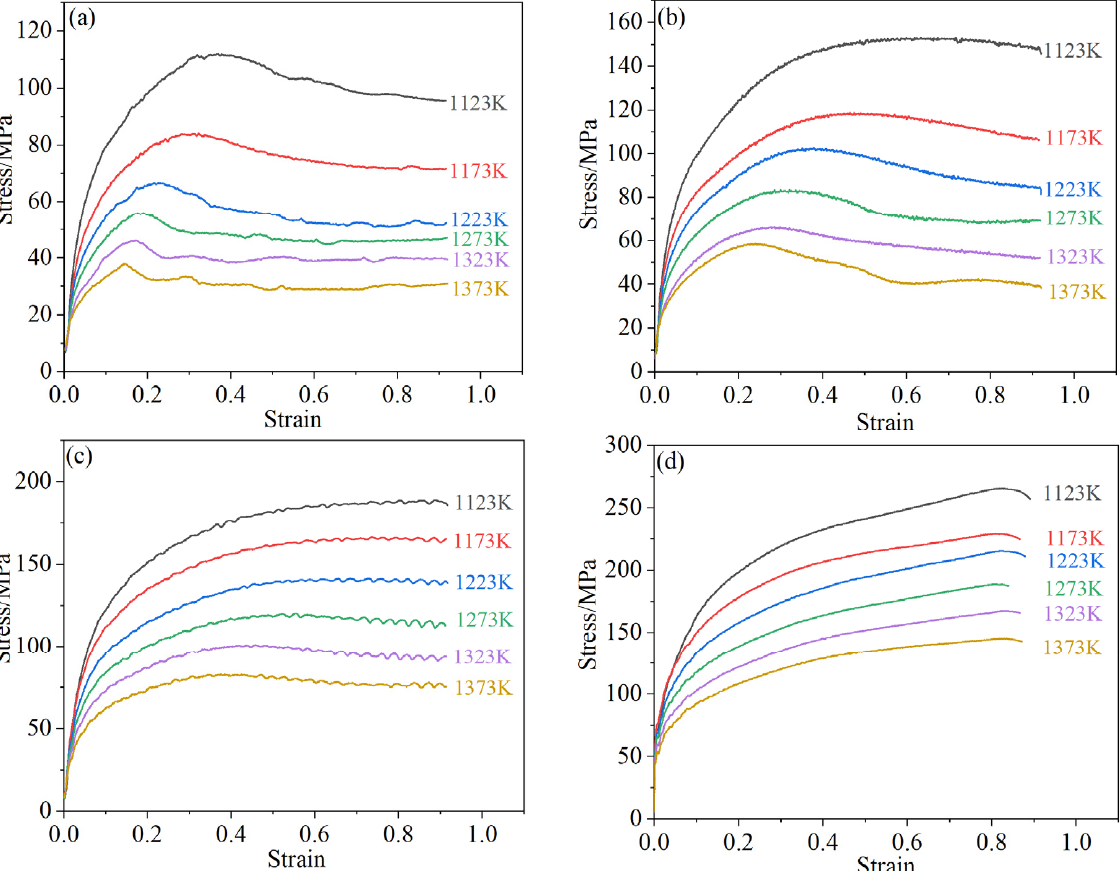
Figure 2. True stress–true strain curves of Q345 steel at different strain rates: ( a ) 0.01 s − 1 ; ( b ) 0.1 s − 1 ; ( c ) 1 s − 1 ; ( d ) 10 s − 1 .